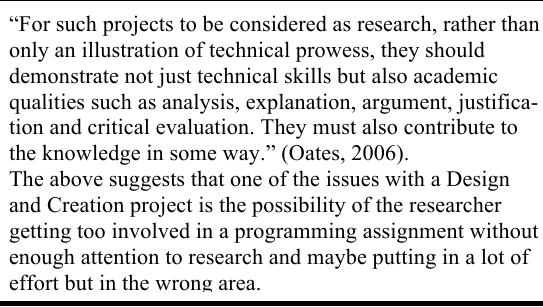
Figure 2. Critical thinking through reflection